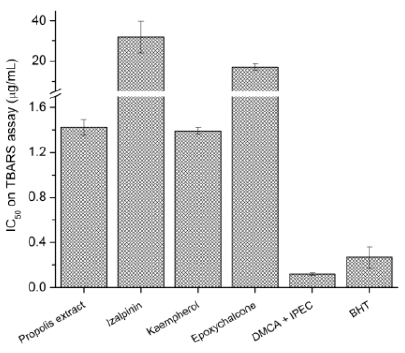
Figure 5. Comparison of IC 50 levels of tested compounds isolated of propolis extract in TBARS assay. Data represent the mean ± SEM (n = 3).